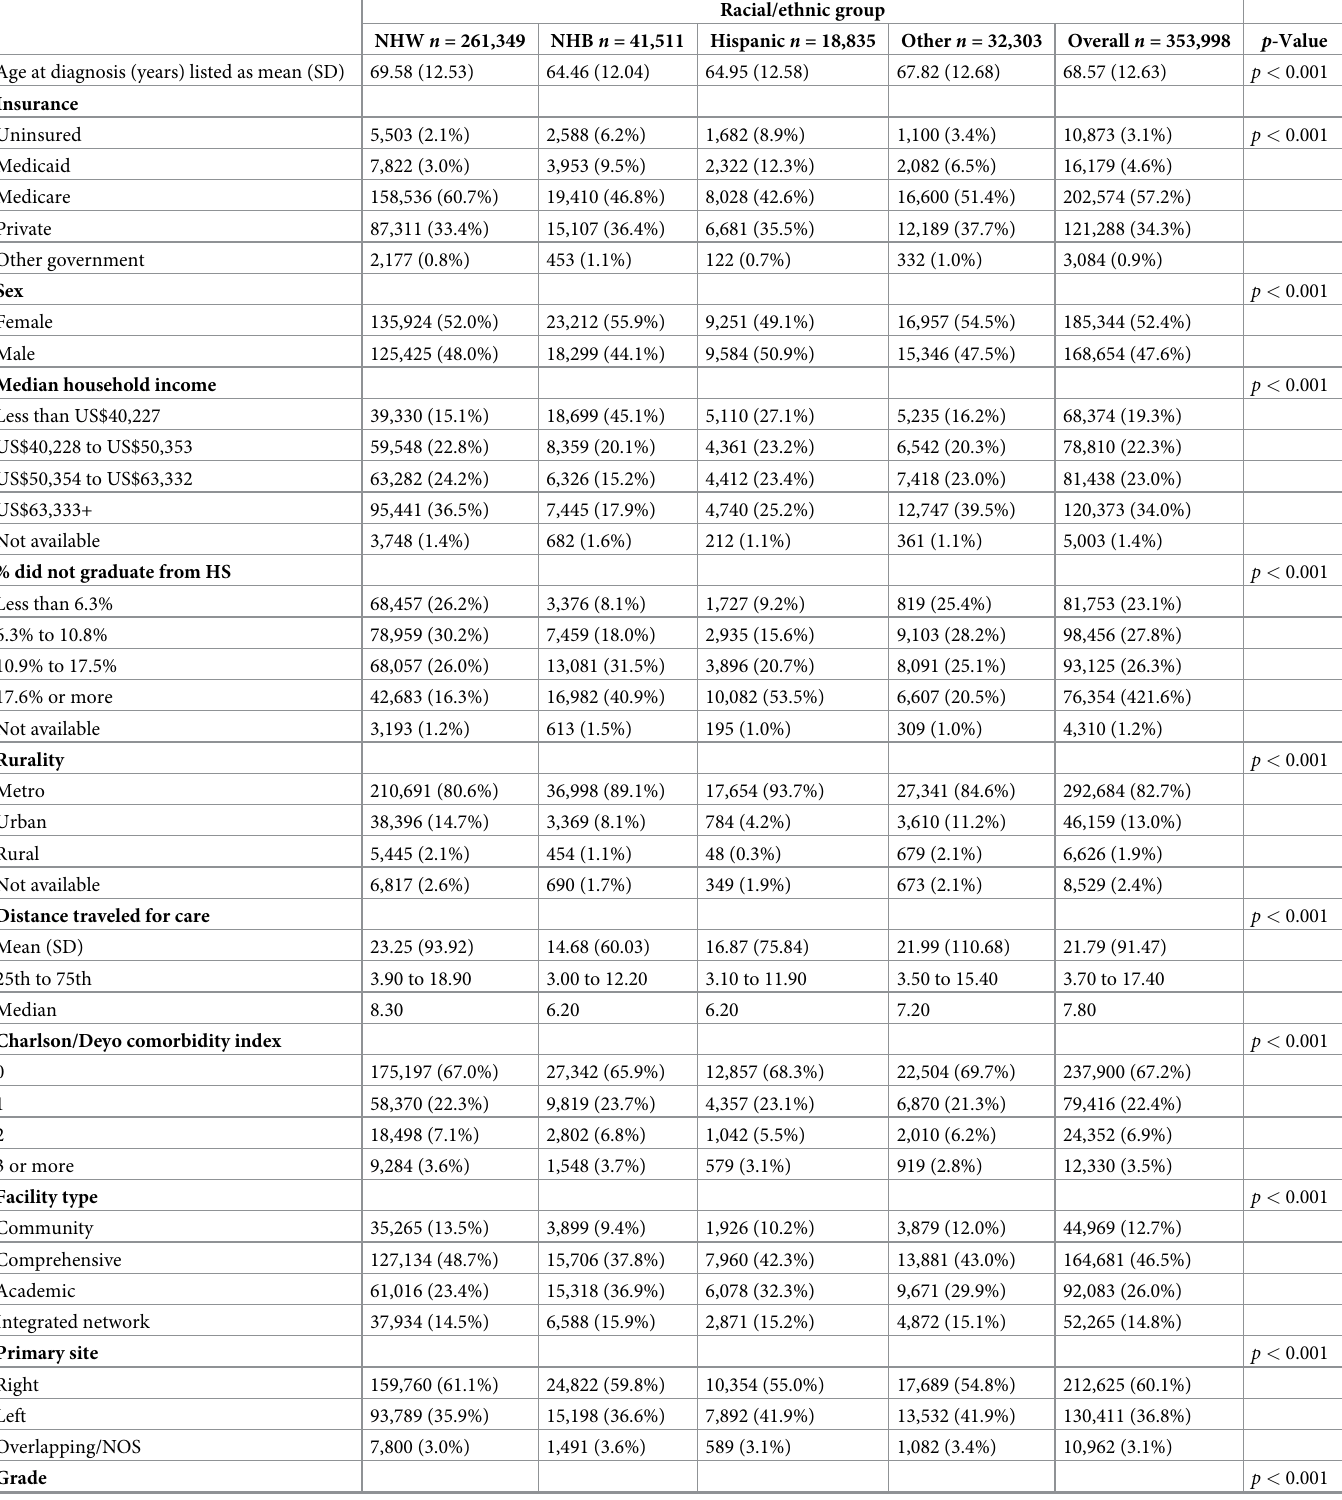
Table 1. Cohort demographics by race/ethnicity, 2006 to